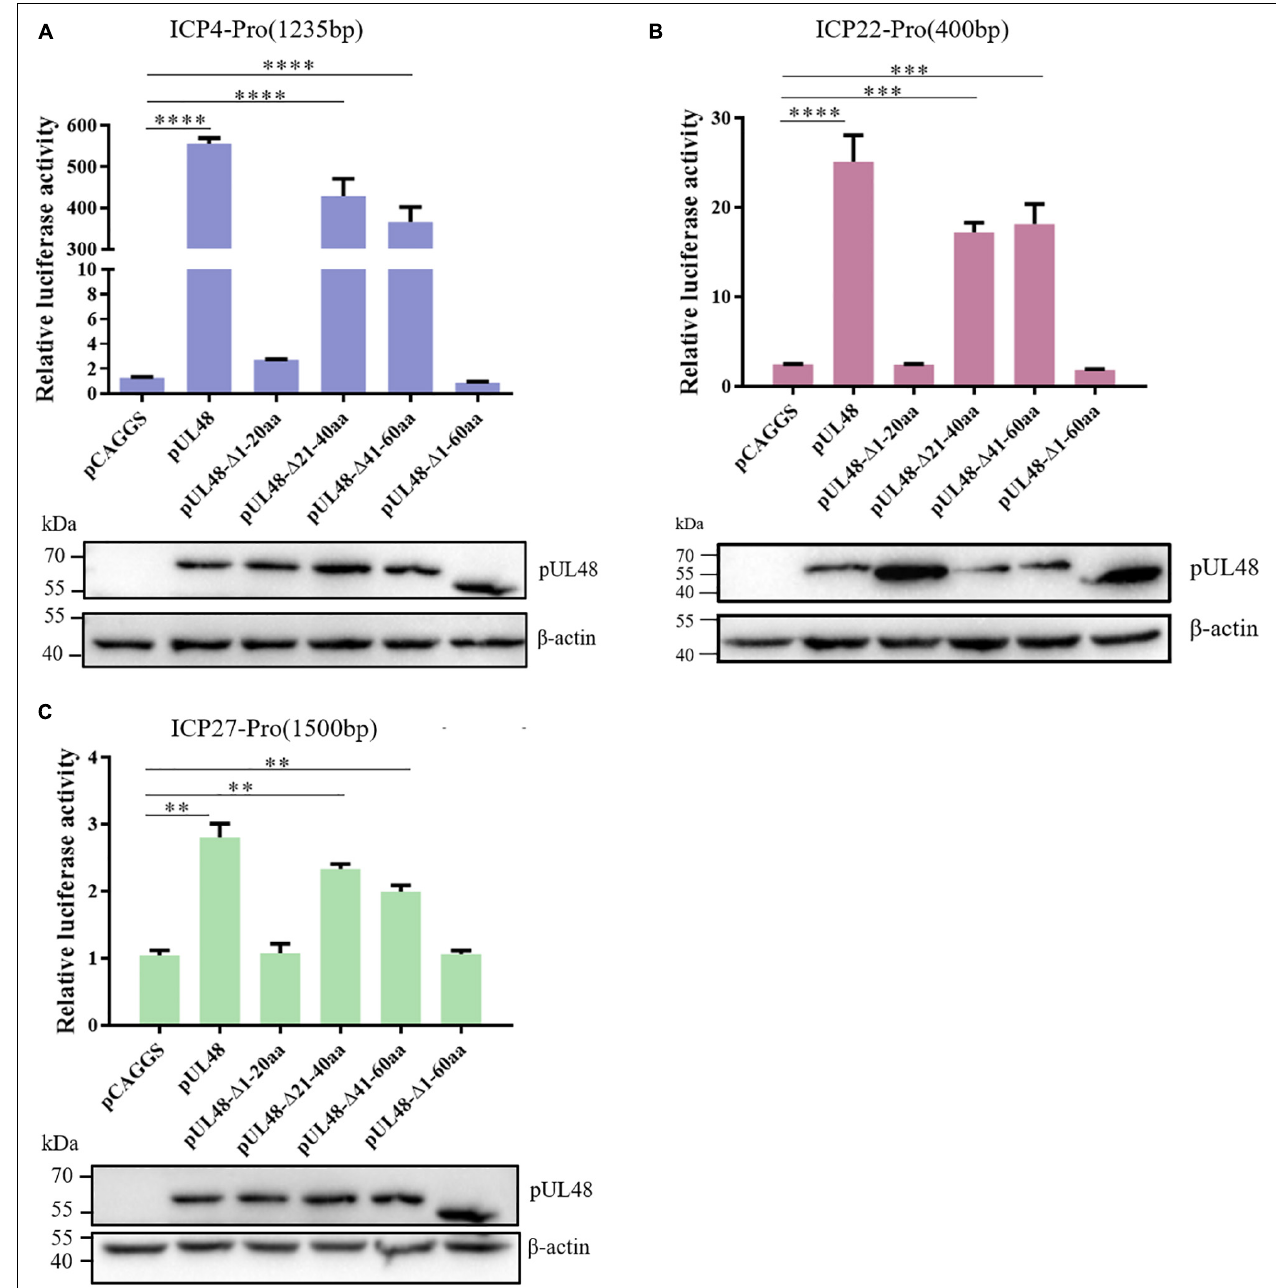
FIGURE 5 | Identification of the core region of the DPV pUL48 transcriptional activation domain. The regulation of ICP4/ICP22/ICP27 promoter by a deletion in different regions of the pUL48 transcriptional activation domain. The N-terminal-truncated plasmids of pUL48 were cotransfected into DEF with ICP4-Pro (1,235 bp), ICP22-Pro (900 bp), ICP27-Pro (1,500 bp), and pRL-TK. pCAGGS was the negative control, and pCAGGS-pUL48-HA was the positive control. Cell samples were collected 24 h after transfection, and the activity of each promoter was detected by a dual-luciferase reporting system. The pUL48 N-terminal-truncated plasmid was transfected into DEF. At 24 h after transfection, cellular protein samples were collected for Western blot analysis. Student’s t -test was used to analyze the differences of the two groups, and the significance was as follows: ∗∗ p < 0.01, ∗∗∗ p < 0.001, ∗∗∗∗ p < 0.0001.